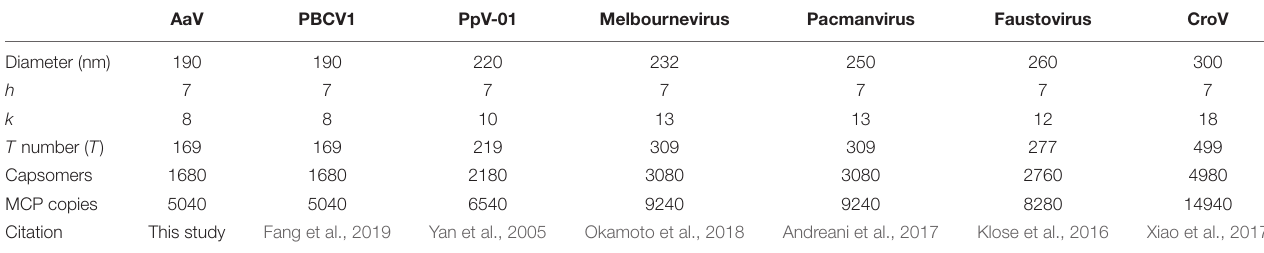
TABLE 1 | Characteristics of structural studies of large icosahedral viruses.